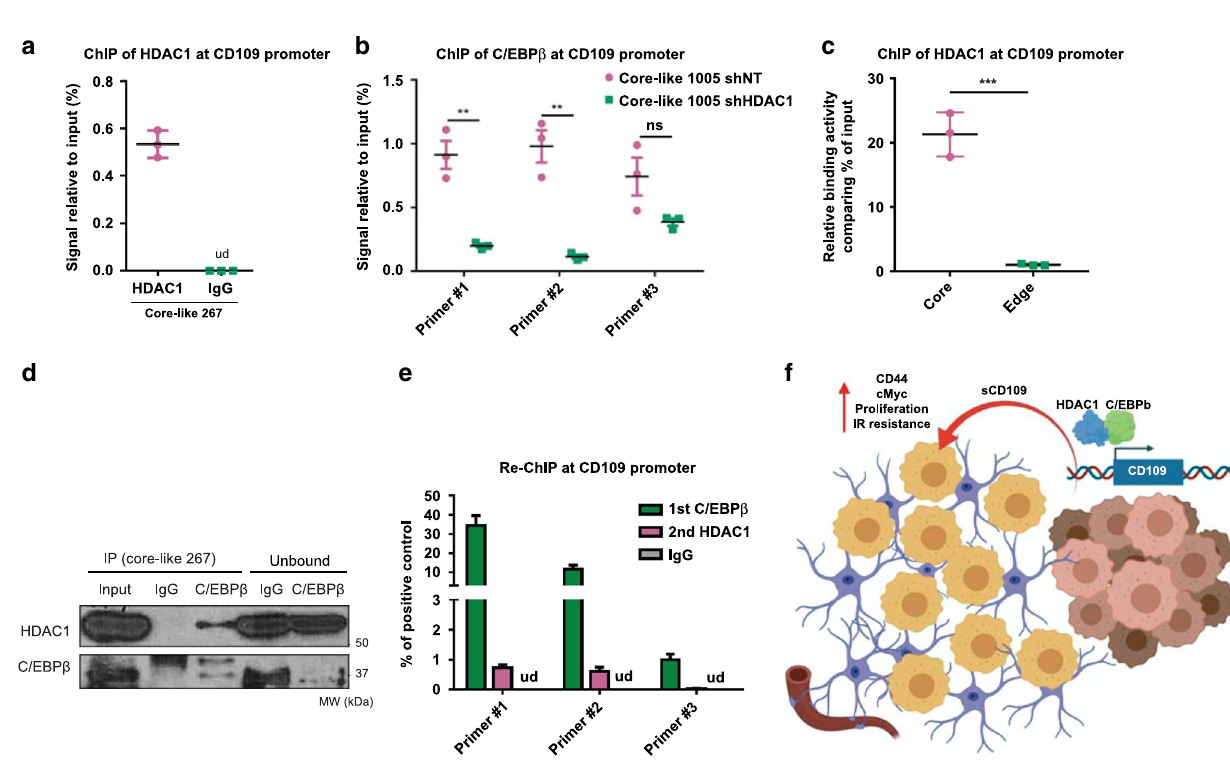
Fig. 8 HDAC1 regulates transcription of CD109 via C/EBP β . a ChIP analysis showing enrichment of HDAC1 at CD109 promoter region in core-like 267 GBM spheres. ud- undetected, n = 3 independent samples per group. b ChIP analysis showing enrichment of C/EBP β at CD109 promoter region in core-like 1005 GBM spheres infected with shNT or shHDAC1, n = 3 independent samples per group; ns, not signi fi cant. c ChIP analysis showing binding of HDAC1 to CD109 promoter region in 1051 core and edge GBM spheres. n = 3 independent samples per group. d Co-immunoprecipitation of HDAC1 in core-like 267 GBM spheres with antibodies against C/EBP β . e Re-ChIP analysis using anti-C/EBP β antibodies for fi rst precipitation, followed by second immunoprecipitation with antibodies against HDAC1 and subsequent PCR with primers spanning promoter region of CD109 . n = 3 independent samples per group. ud- undetected. f Proposed molecular mechanism of intercellular crosstalk between core and edge GBM cells via soluble CD109 protein. HDAC1-C/ EBP β -CD109 signaling induces upregulation of CD44 and c-Myc in edge cells and ultimately leads to the increased proliferation and therapy resistance. a – e Data are mean ± s.d. Signi fi cance was calculated by unpaired, two-tailed t- test not adjusted for multiple comparison with ** p < 0.01; *** p <